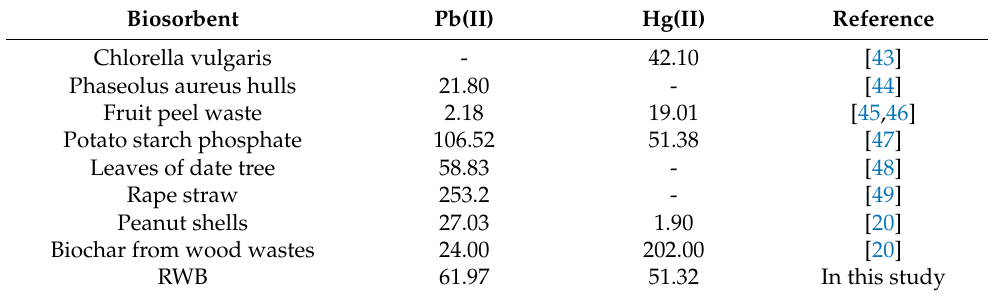
Table 5. Maximum biosorption capacities (mg/g) of various biosorbents for Pb(II) and Hg(II)